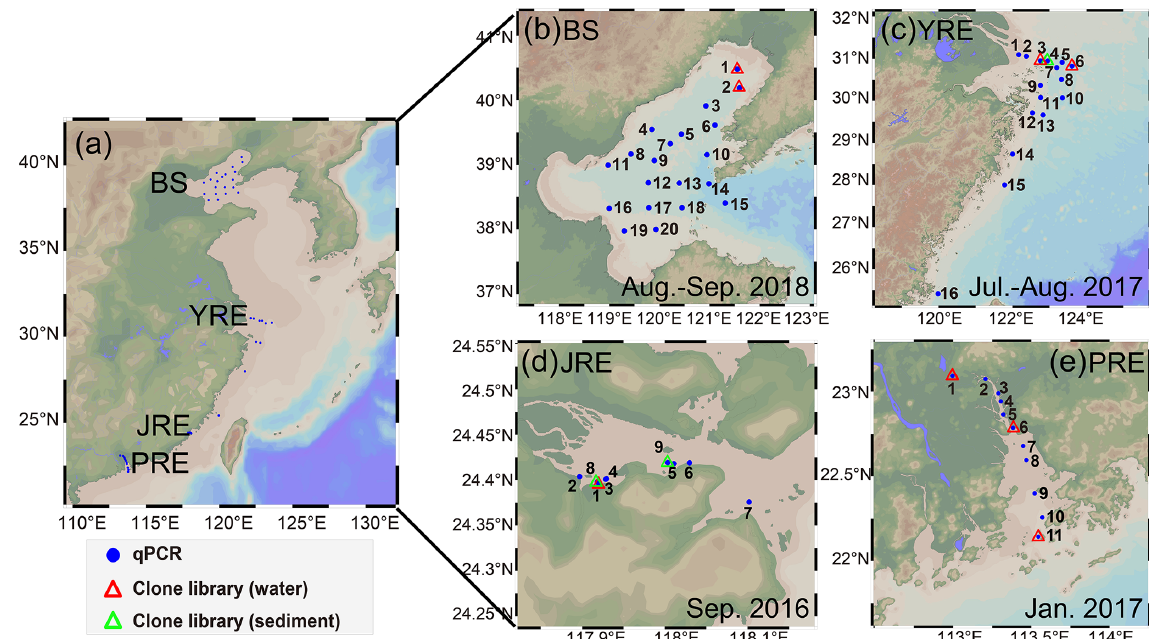
Figure 1. (a) Sampling sites in the four estuaries along China’s coastline; (b) Bohai Sea (BS); (c) Yangtze River estuary (YRE); (d) Jiulong River estuary (JRE); (e) Pearl River estuary (PRE). The sampling time for each region is shown in the subplots. The figure was produced by Ocean Data View 5.2.0 (http://odv.awi.de/, last access: 19 August 2020).